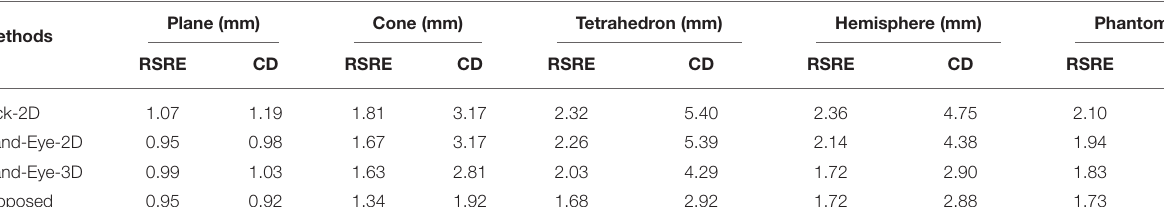
TABLE 1 | Comparison of different calibration methods. Methods